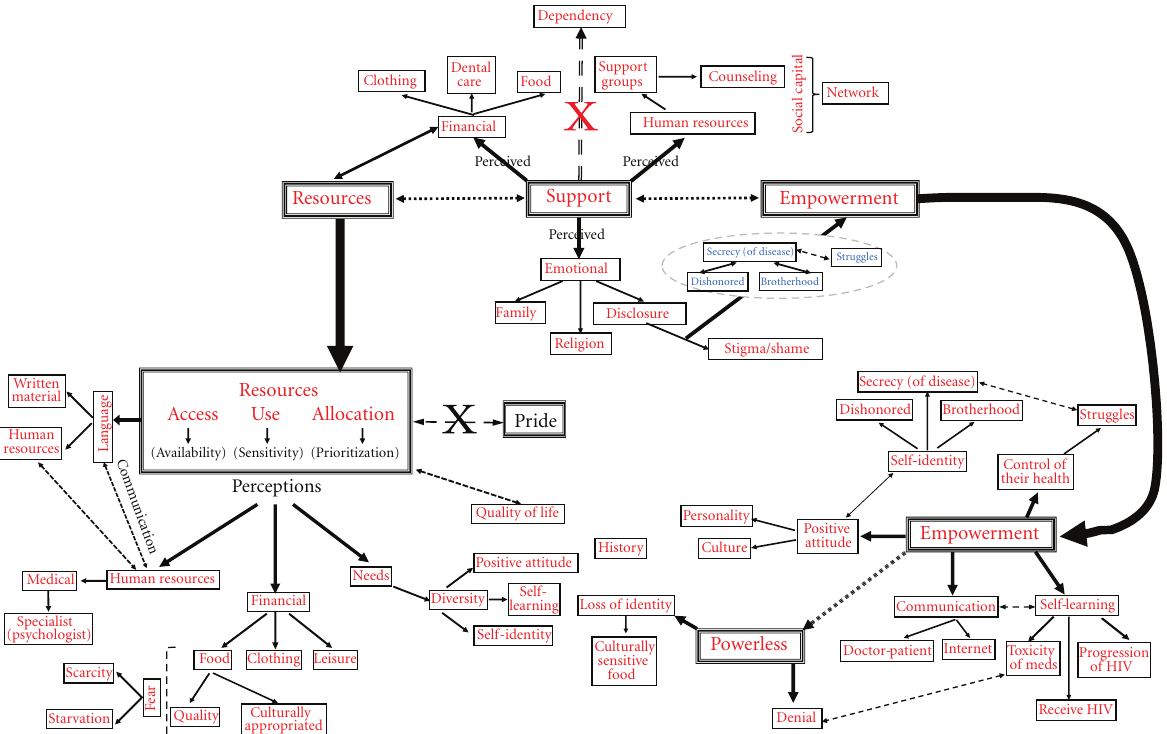
Figure 1: Relationship of themes and codes of the categories resources, support, and empowerment using mapping technique (adopted from